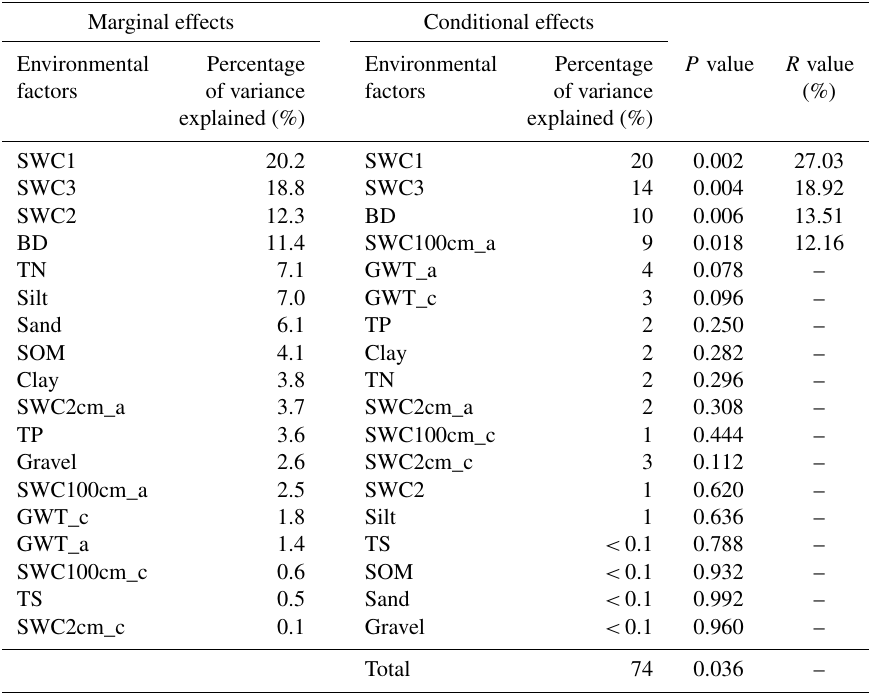
Table 2. The selection of the key influencing factors based on the marginal and conditional effects obtained from the forward selection of the Monte Carlo